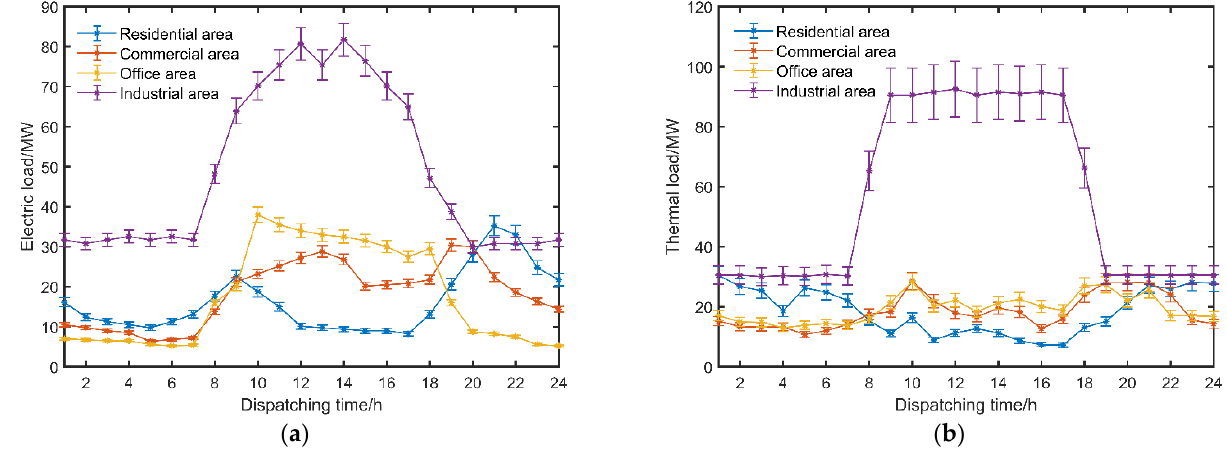
Figure 1. Typical characteristics of each functional area: ( a ) Electric load; ( b ) Thermal load.